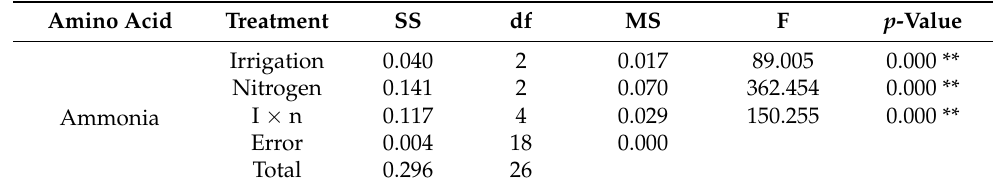
Table 6. ANOVA to determine the effect of irrigation and nitrogen application on ammonia in sunflower seed kernels.